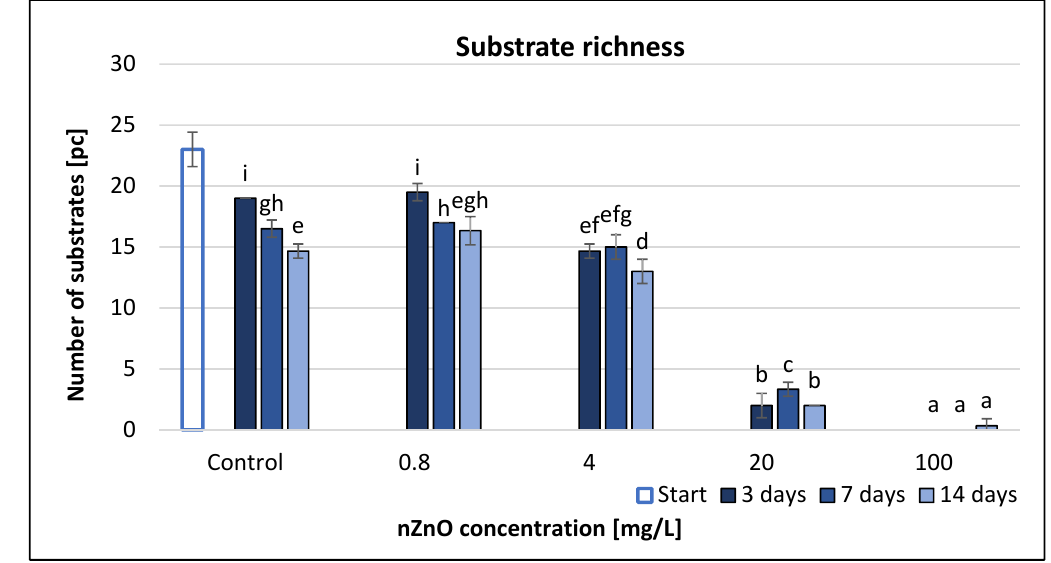
Figure 3. The effect of ZnO nanoparticles on freshwater substrate richness value. Letters on the columns indicate significant differences (level of significance: p < 0.05).